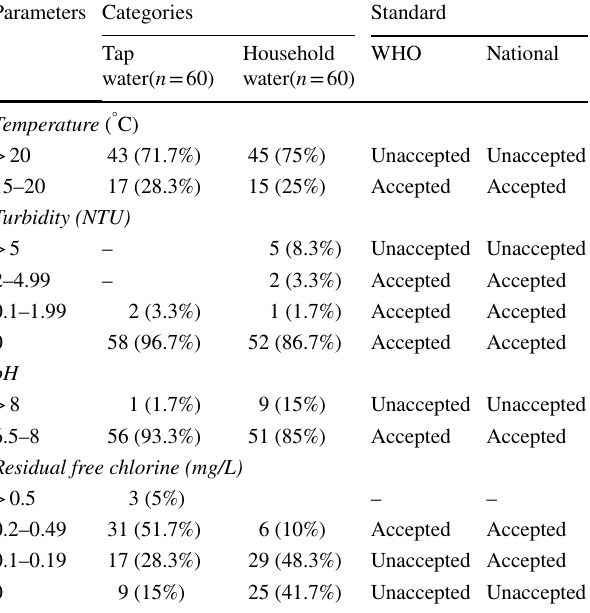
Table 1 Comparison of physicochemical parameters of drinking water for household and tap water samples with WHO recommended values, Hawassa, 2016 Parameters